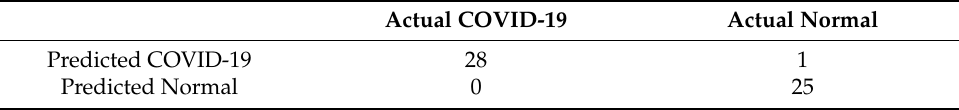
Figure 4. Accuracy and AUC of transfer learning models for COVID-19 detection from chest X-rays.